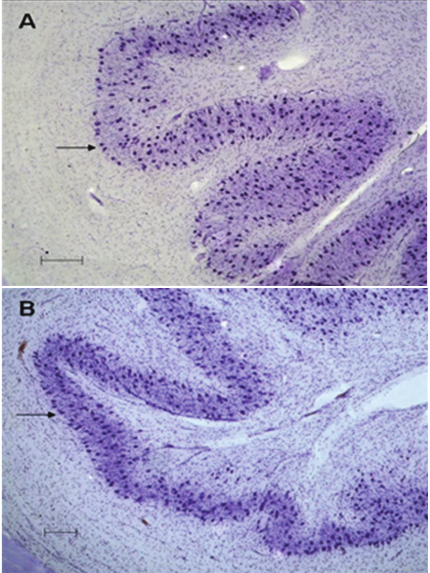
at the edge of principle olive in an autistic brain. In A (autism) the clustering of neurons can be seen as a single row at the edge of the principle olive (arrow), whereas in B (control) these neurons are more scattered although some neurons do exist on the edge of the ribbon (arrow). Scale bars = 200 m. 𝜇𝜇